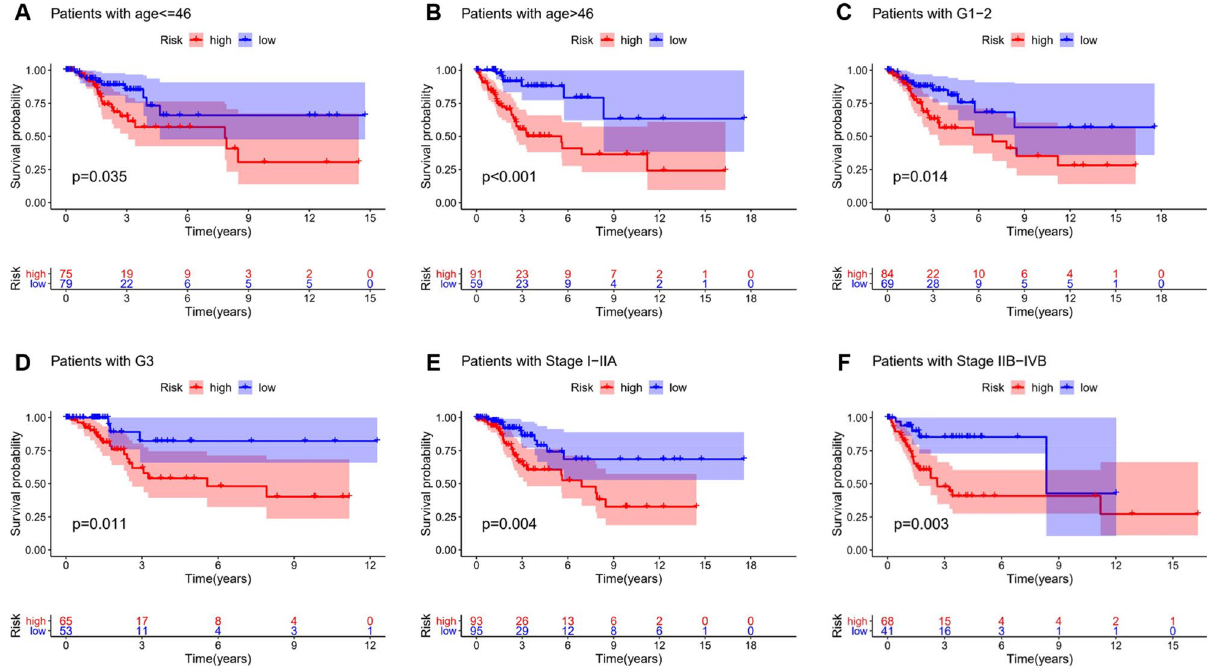
Figure 5. Stratification analyses by age, histological grade and FIGO stage. Kaplan–Meier curve analysis of overall survival in high-risk and low-risk groups for younger patients (age ≤ 46) ( A ) and older patients (age > 46) ( B ). For early-grade patients (histological grade 1–2) ( C ) and late-grade patients (histological grade 3) ( D ). For early-stage patients (FIGO stage I–IIA) ( E ) and late-stage patients (FIGO stage IIB–IVB) ( F ). Statistical analysis was performed using the log-rank test and univariate Cox analysis.